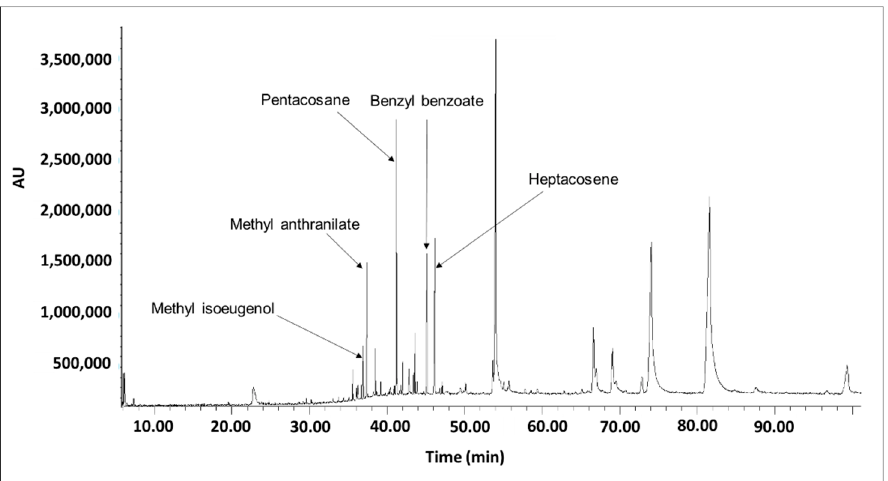
Figure 3. Chromatogram showing characteristic compounds for supercritical tuberose extract.